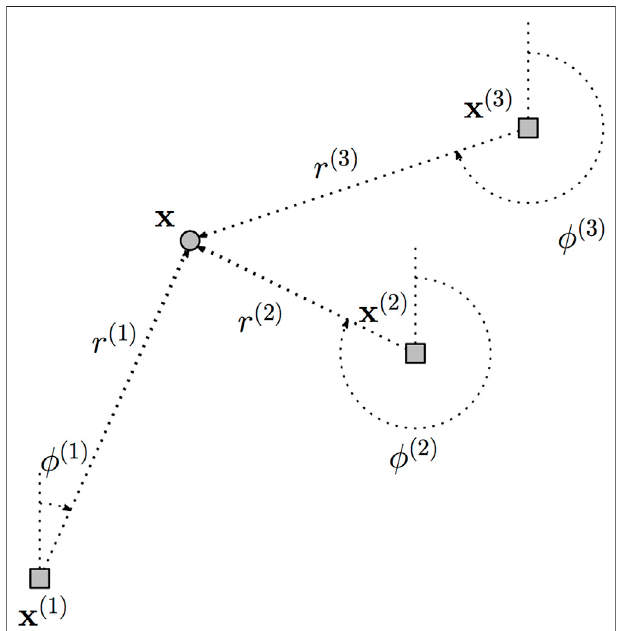
FIGURE2| Depictionofdatarepresentation.Asinglelocation x isshown relative to three source points x (1) , x (2) , and x (3) , and the polar coordinates ( r (1) , ϕ (1) ) ( r (2) , ϕ (2) ), and ( r (3) , ϕ (3) ) label the distances and angles to each